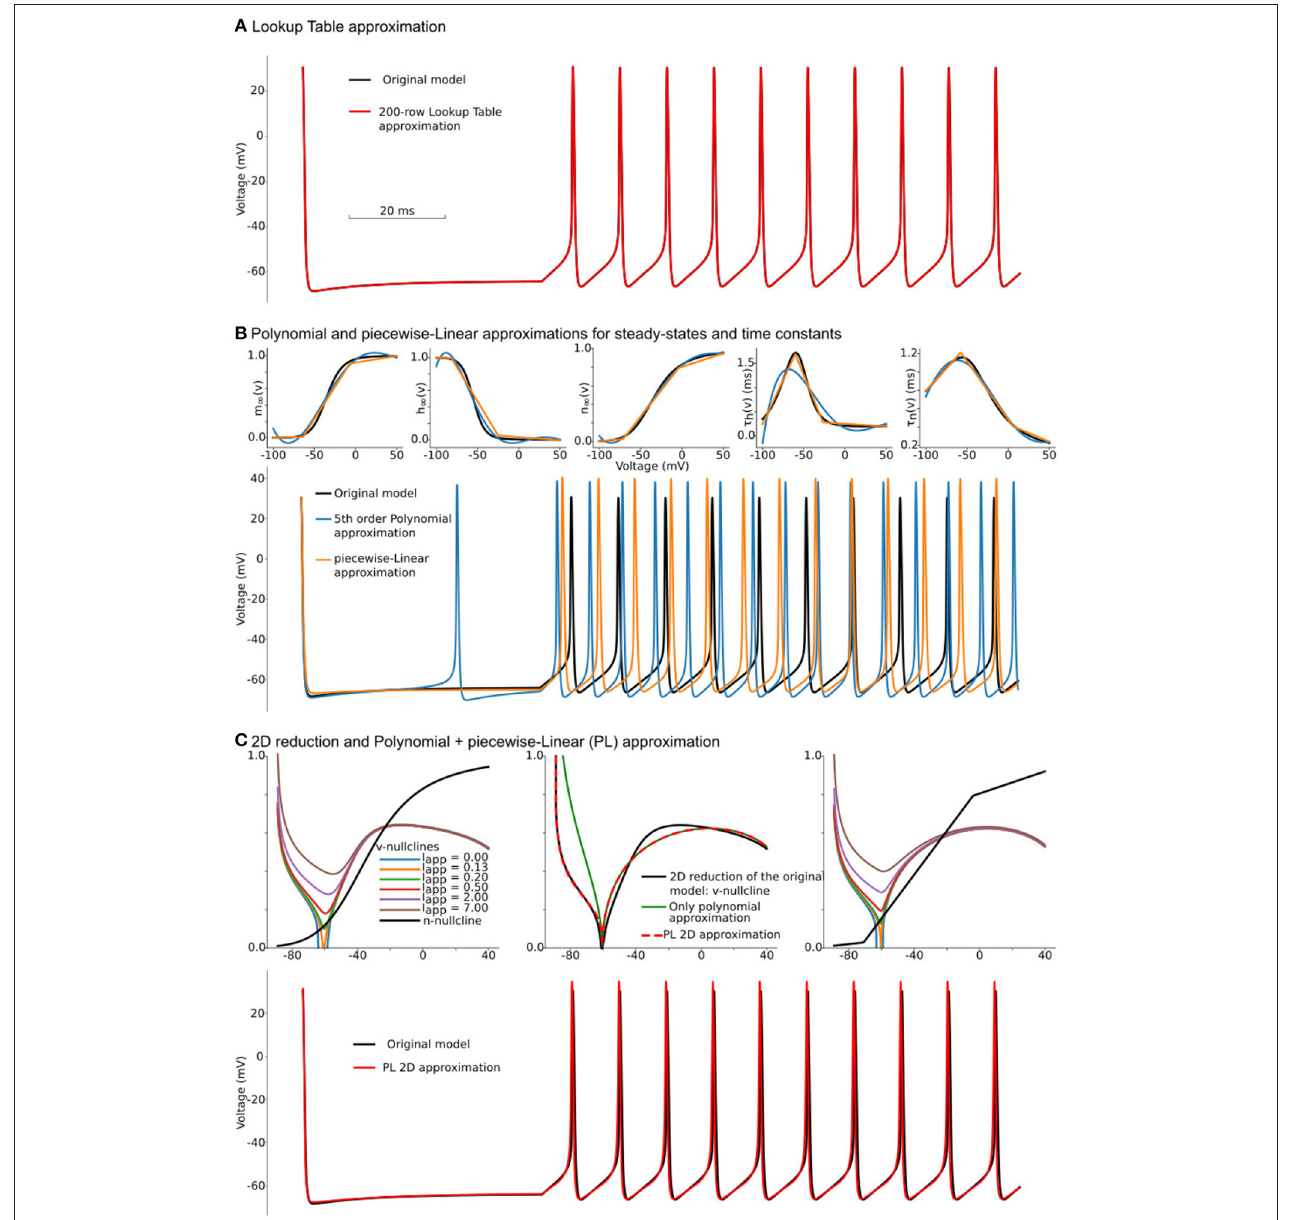
FIGURE 1 | Constructing approximations of Wang and Buzsáki biophysical model. (A) Voltage traces for the original model (black line) overlapped with solution based upon lookup-table approximation (red line). (B) Top from left to right : Steady-state for fast sodium activation ( m ∞ ( v )), inactivation ( h ∞ ( v )), and delay-rectifier potassium activation ( n ∞ ( v )) and time constants for sodium inactivation ( τ h ( v )) and potassium activation [ τ n ( v )] for the original model and two approximations: black lines—original model, blue lines—5 th order polynomial interpolation, orange lines—piecewise-Linear approximation. Bottom : Voltage traces for the same approximations. (C) Top left : voltage nullclines at different applied currents ( I = I app ) for the original model reduced to 2 dimensions. Top center : Construction of only polynomial (green line) or Polynomial+piecewise-Linear approximation (PL 2D, red dashed line) from the original model after the reduction (black line). Top right : nullclines for the PL2D model (the same color-code and applied currents as in the left plot) Bottom : Voltage traces for original model (black line) and PL2D approximation (red line).